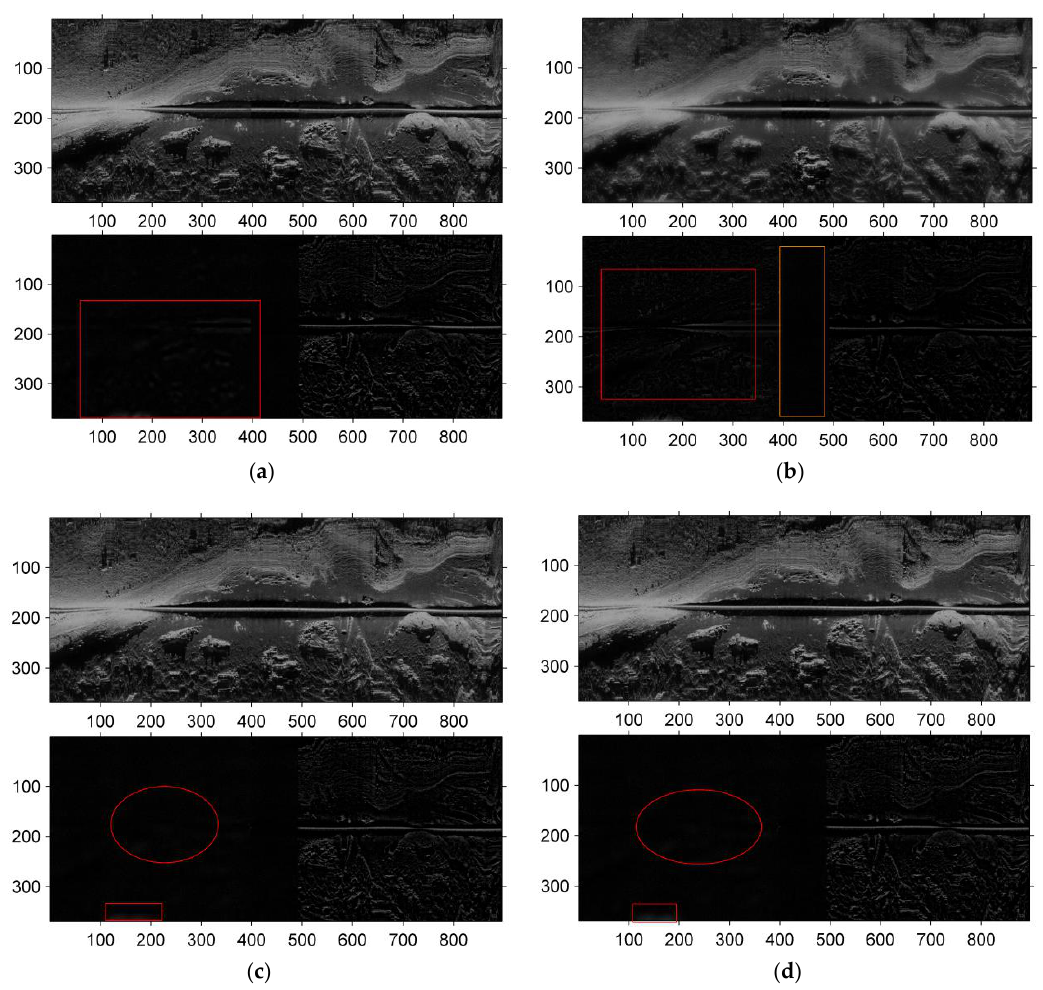
Figure 9. Fused image (top) and difference image (bottom) of Data 2. ( a ) Energy_Max. ( b ) Dire_Contrast_Max. ( c ) IPCNN (MSF). ( d ) IDPCNN (NSML).